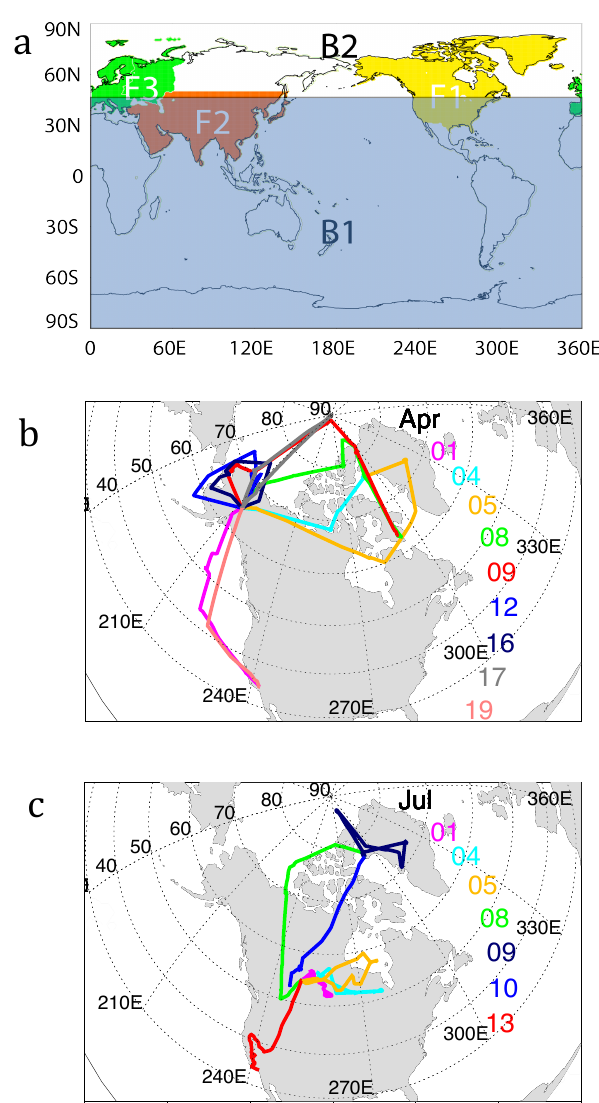
Fig. 1. (a) Regions for tagged CO emissions. In this work we use Figure 1: (a) Regions for tagged CO emissions. In this work, we use 3 tagged fossil fuel CO tracers 3 tagged fossil fuel CO tracers and 2 tagged biomass burning trac- and 2 tagged biomass burning tracers: F1. North America fossil fuel (NAFF, yellow), F2. Southern ers: F1. North American fossil fuel (NAFF, yellow), F2. Southern Asian fossil fuel (ASFF, red), F3. Europe fossil fuel (EUFF, green), B1. Non-­‐Boreal biomass burning Asian fossil fuel (ASFF, red), F3. Europe fossil fuel (EUFF, green), (NBBB, light-­‐blue shaded area), and B2. Boreal biomass burning (BOBB, non-­‐light-­‐blue area). (b) and (c) NASA DC-­‐8 flight tracks during ARCTAS-­‐A (April based at Fairbank, USA) and ARCTAS-­‐B (July B1. Non-boreal biomass burning (NBBB, light-blue shaded area), based at Cold Lake, Canada), respectively. and B2. Boreal biomass burning (BOBB, non-light-blue area). (b) and (c) NASA DC-8 flight tracks during ARCTAS-A (April, based at Fairbank, USA) and ARCTAS-B (July, based at Cold Lake, Canada),